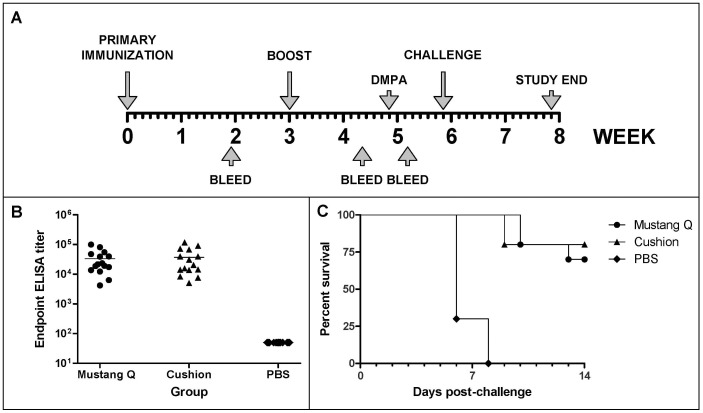
Chromatography-purified ACAM529 is as immunogenic and protective as cushion-purified ACAM529.Panel A is a schematic representation of the animal study schedule, long labeled arrows represent viral inoculations (immunizations were performed sc and challenge was intravaginal) short arrows symbolize bleeds, hormone injection (DMPA = depot medroxyprogesterone acetate or Depo-Provera) and the study end day, as indicated. Panel B shows endpoint ELISA titers against a commercially available, purified HSV-2 viral lysate for immunized mice and Panel C depicts survival of animals as a % of the total (n = 15 animals). Mice were immunized either with Mustang® Q (•)- or sucrose cushion (▴)-purified ACAM529 or a placebo (♦)(PBS). Both vaccine preparations elicited similar anti-HSV-2 ELISA titers (Kruskal-Wallis Test P = 0.99) and similar levels of protection against severe virus challenge with wild type HSV-2 strain 333 (Mantel-Cox Test P<0.0001).